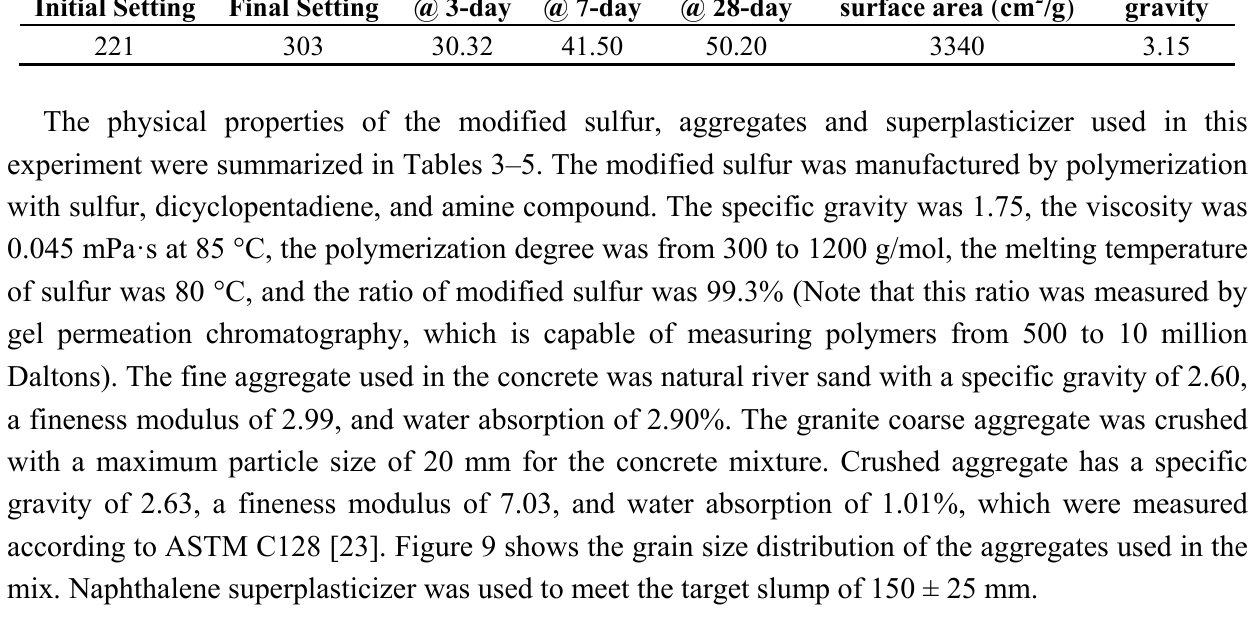
Figure 9. Grain size distribution of fine and coarse aggregate.